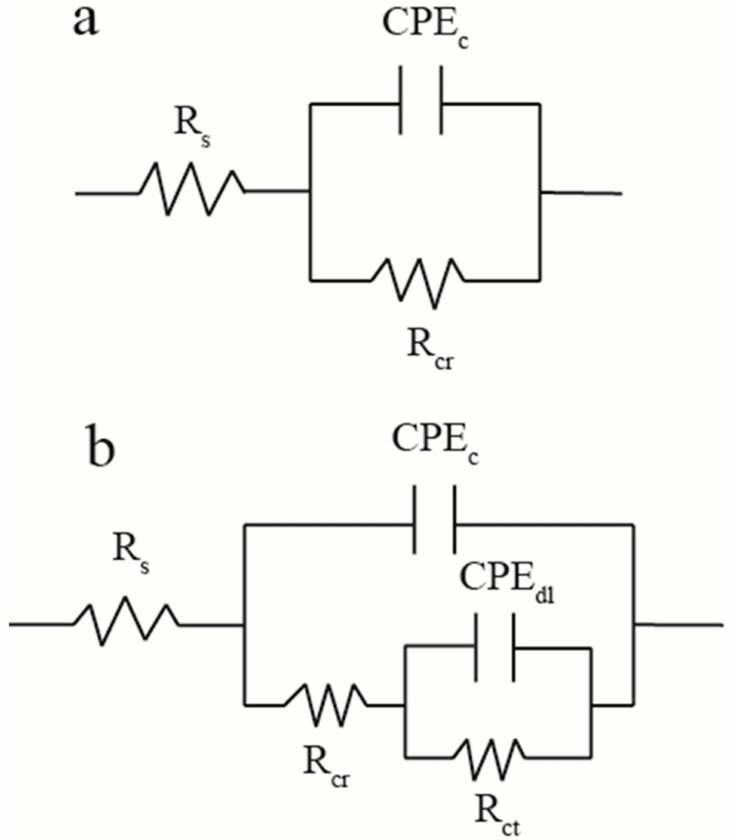
Figure 10. The equivalent electrical circuit used for fitting EIS data ( a , b